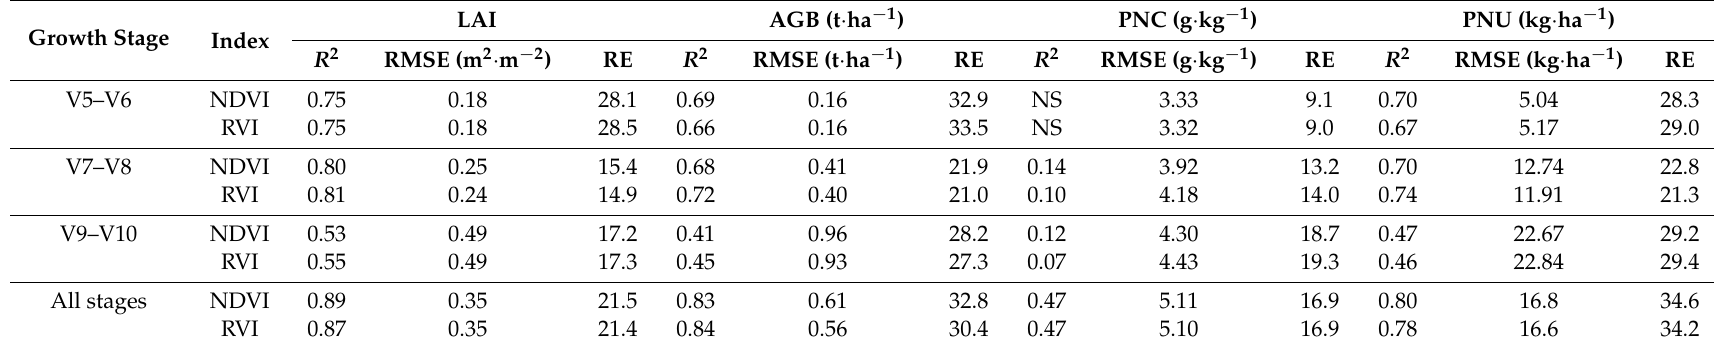
Table 4. Validation results of the GreenSeeker sensor-based indices (normalized difference vegetation index (NDVI) and ratio vegetation index (RVI)) for estimating spring maize leaf area index (LAI), aboveground biomass (AGB), plant N concentration (PNC) and plant N uptake (PNU) at different growth stages across 2014 and